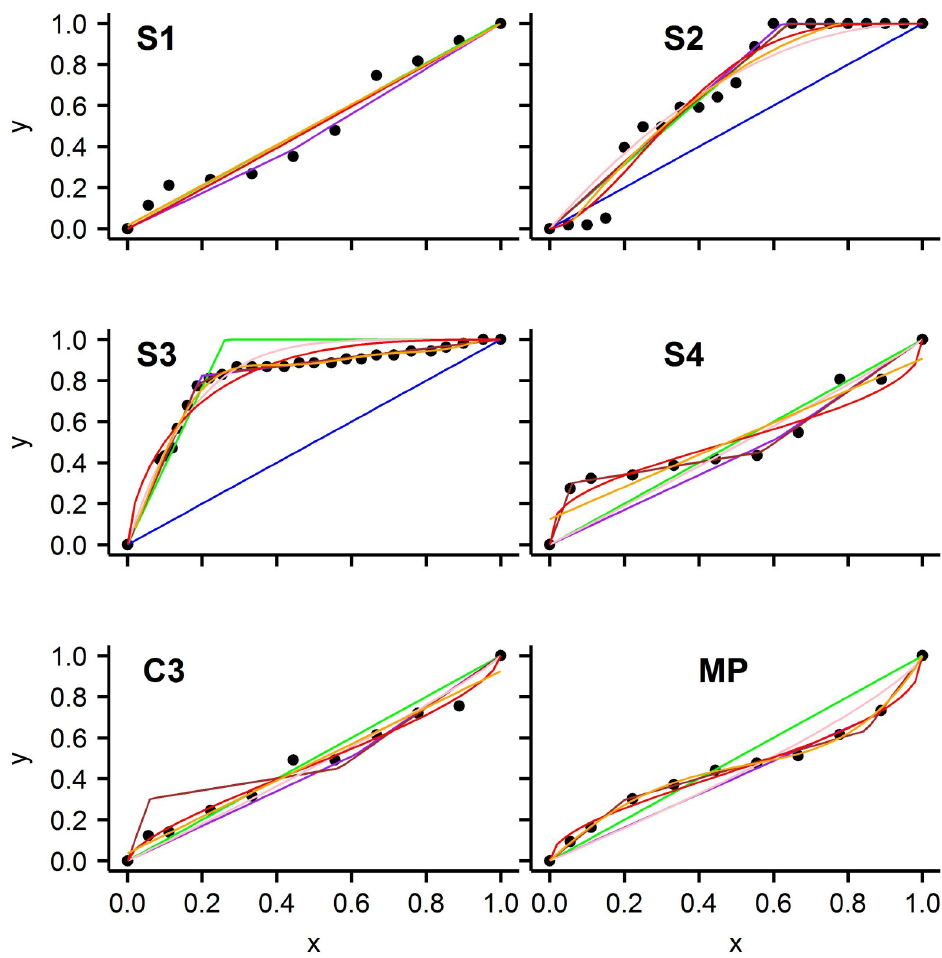
Fig 3. Results of fitting all 7 models to each of six selected animals. Each panes is a separate animal and the name of the best fitting model for the animal is given at the top of the panel. Black dots are the observed data points. Solid lines are: blue = S1, green = S2, purple = S3, brown = S4, pink = C2, red = C3, orange = MP.